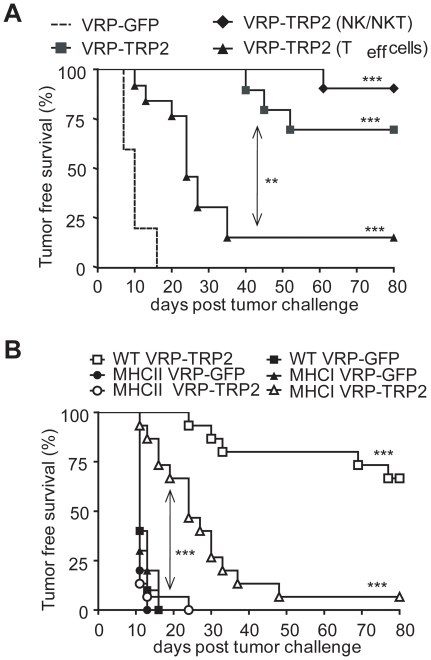
VRP-TRP2 anti-tumor effect is only partially CD8+ T cell dependent.(A) Kaplan-Meier tumor-free survival curves of 10 mice per group vaccinated with either control VRP-GFP or VRP-TRP2 and treated with depleting antibodies for NK/NKT or T cells after the last vaccination. (B) Kaplan-Meier tumor-free survival curves of 15 WT, MHC I and MHC II deficient mice per group vaccinated with either control VRP-GFP or VRP-TRP2. *** P<0.0001, ** P<0.001.